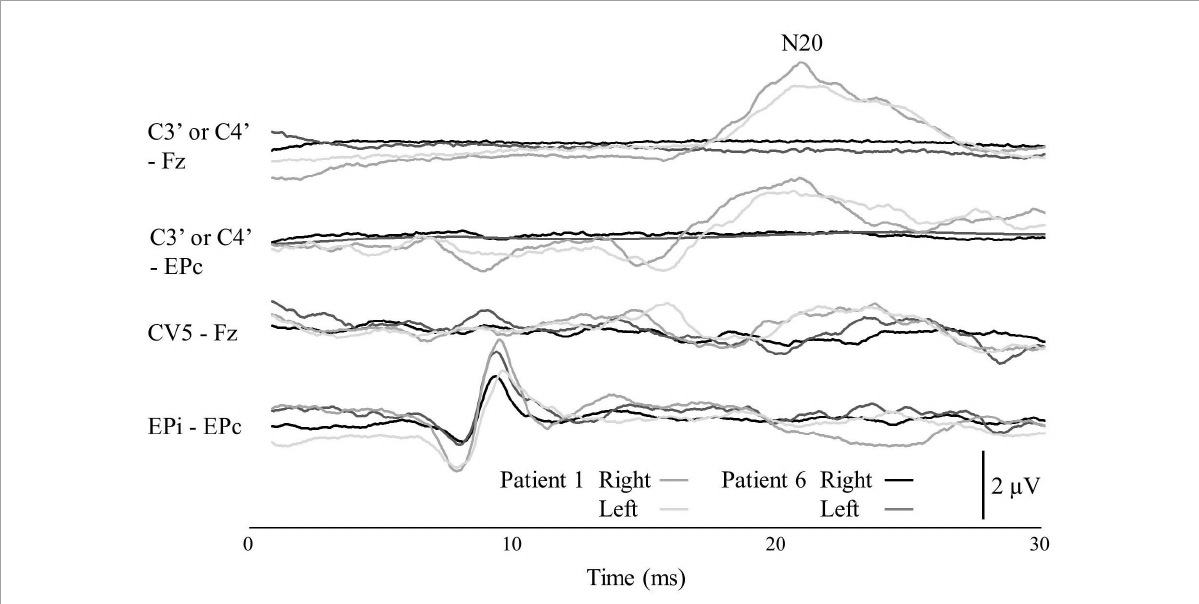
FIGURE2 The SSEP of Patients 1 and 6. The locations of the four recording electrode pairs were: (1) the scalp overlying the contralateral somatosensory cortex (C3 (cid:48) or C4 (cid:48) ) according to the international 10–5 system and front parietal zone (Fpz); (2) C3 (cid:48) or C4 (cid:48) and the contralateral Erb’s point (EPc); (3) the C5 spinous process and the Fpz; and (4) the ipsilateral Erb’s point (EPi) and EPc. The top channel shows the N20 potential.